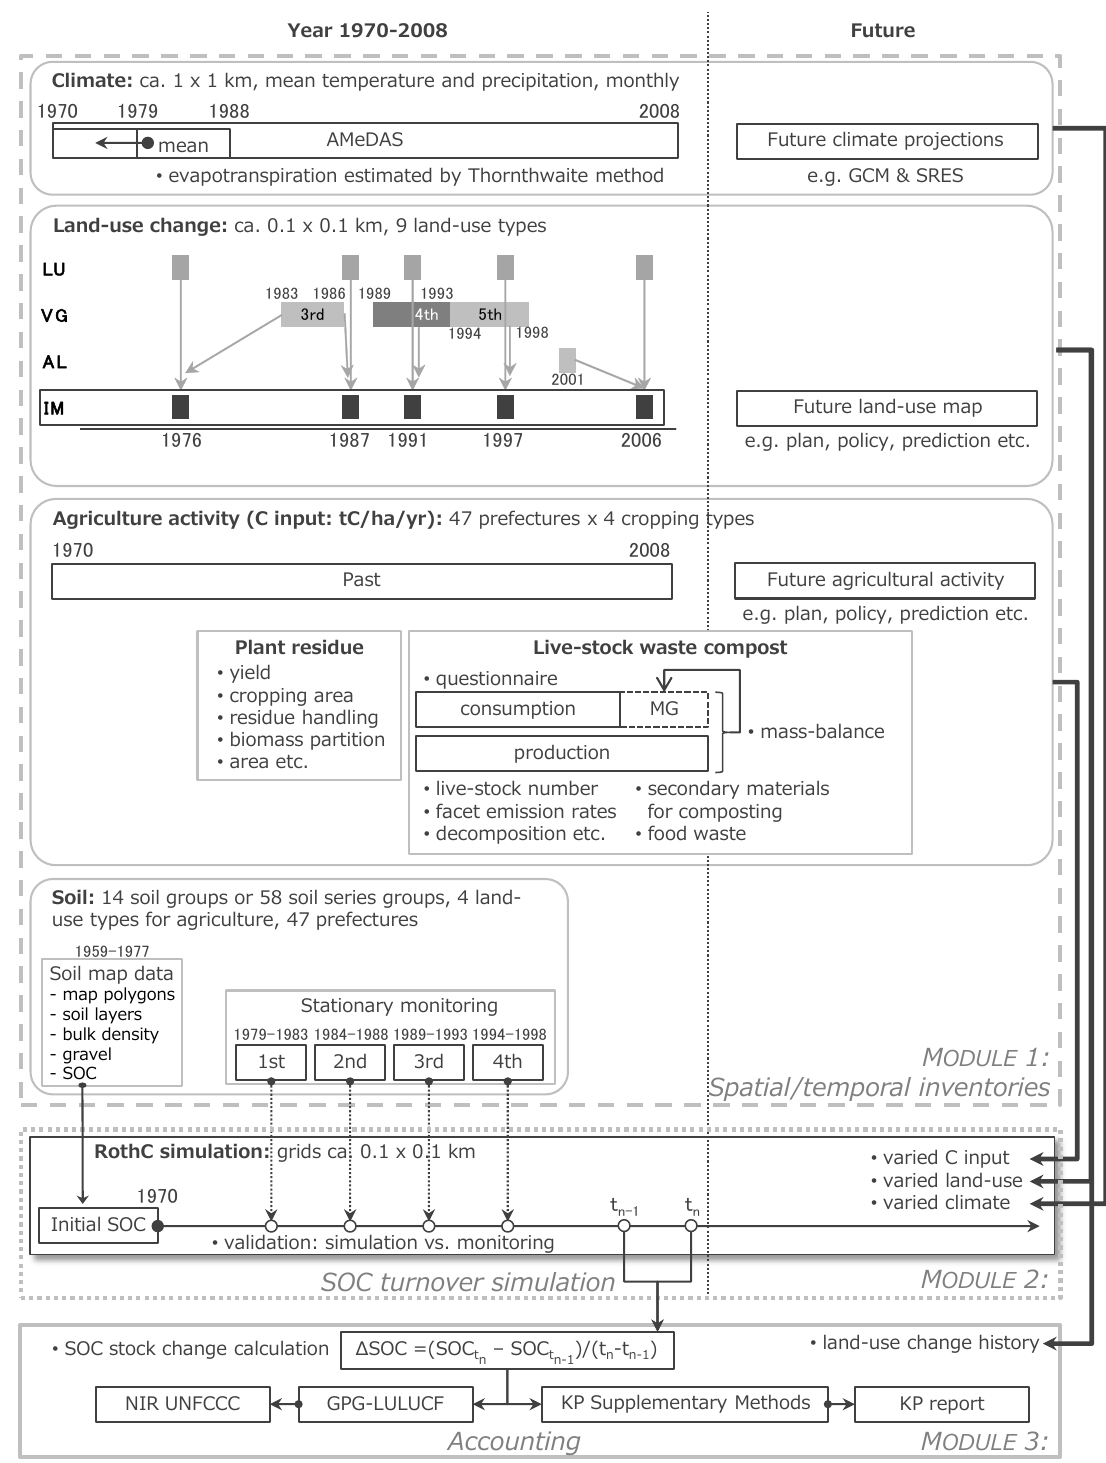
Figure 1. Schematic diagram of the system developed to simulate soil carbon stock change at country-scale using spatially explicit inventories on land-use change, climate, soil, and agricultural activity. The system is designed to be capable to simulate both historical and future soil organic carbon stock change, provided that spatial and temporal inventories are continuous or have appropriate time interval. See the text and Supplement for detailed descriptions on other abbreviated text in figures: SOC – soil organic carbon; LU – land-use map, VG – vegetation map, AL – agricultural field map, IM – interpreted land-use/land-cover map, MG – managed grasslands, GCM – Global Climate Models, SRES – Special Report on Emission Scenarios of IPCC, KP – Kyoto Protocol, and NIR – National Inventory